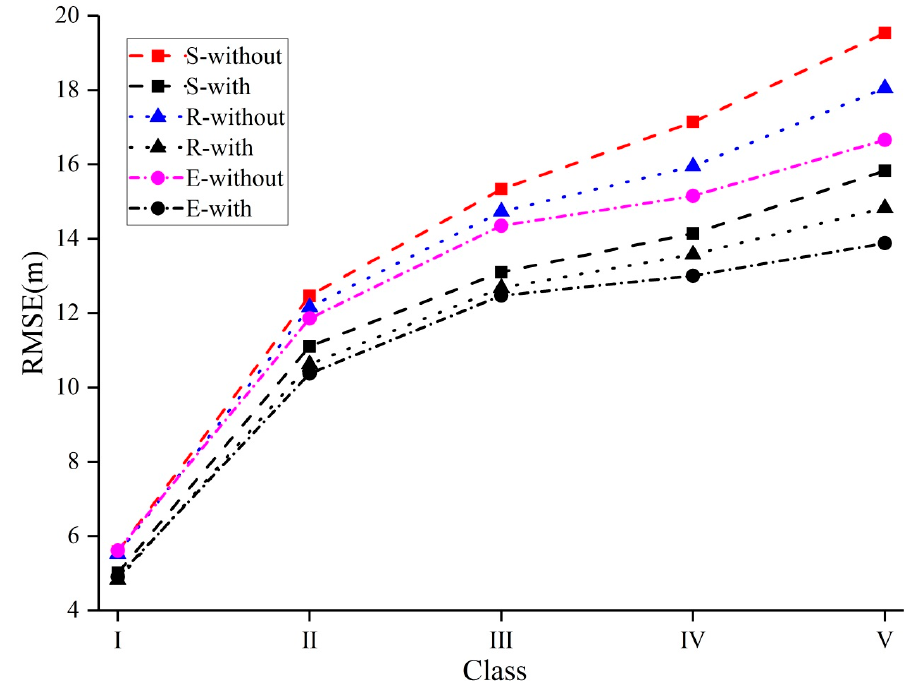
Figure 9. Influence of terrain slope, relief and elevation classes on the RMSEs of SRTM3 DEM without and with data coregistration (I: (0–5°) for slope class, (0–100 m) for relief and elevation classes; II: (5–10°) for slope class, (100–200 m) for relief and elevation classes; III: (10–15°) for slope class, (200–300 m) for relief and elevation classes; IV: (15–20°) for slope class, (300–400 m) for relief and elevation classes; V: (>20°) for slope class, (>400 m) for relief and elevation classes. “S”, “R” and “E” stand for slope, relief and elevation, respectively.).